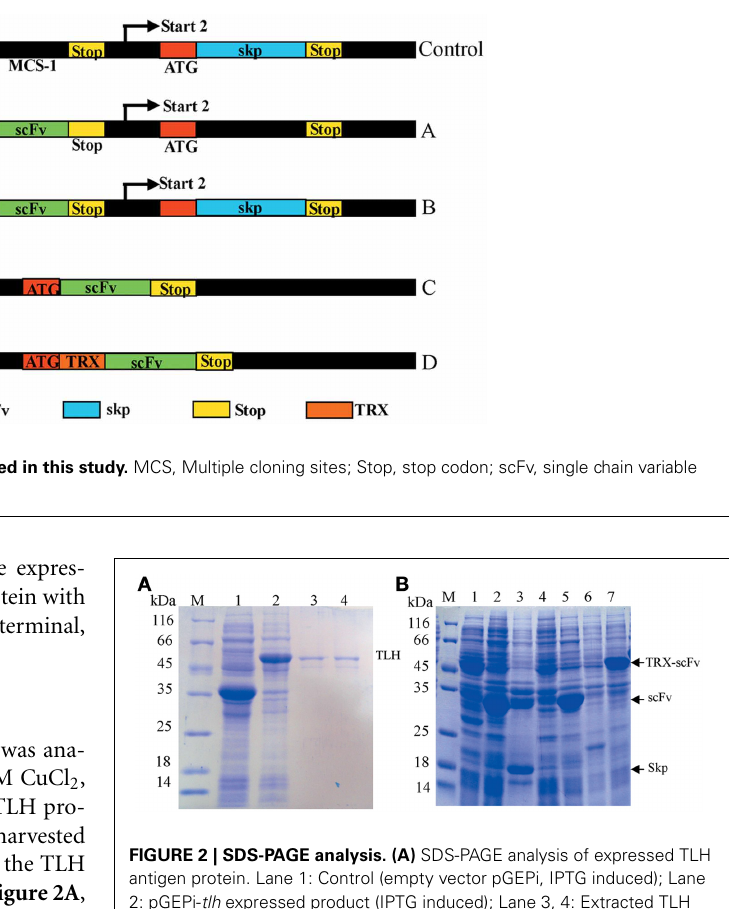
FIGURE 2 | SDS-PAGE analysis. (A) SDS-PAGE analysis of expressed TLH antigen protein. Lane 1: Control (empty vector pGEPi, IPTG induced); Lane 2: pGEPi- tlh expressed product (IPTG induced); Lane 3, 4: Extracted TLH protein (without 6 × His tag); (B) Expression of different scFv constructs